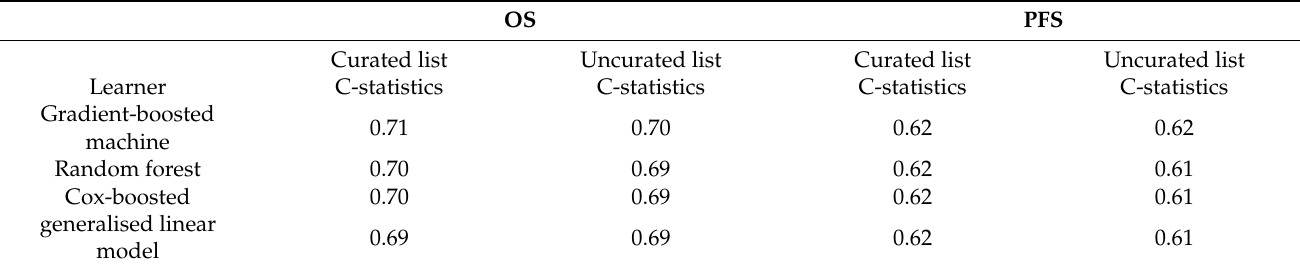
Table 1. Discrimination performance on validation set for overall survival (OS) and progression-free survival (PFS). OS PFS